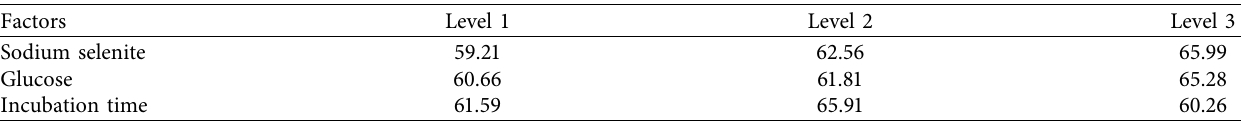
Table 2: The main effects of different levels of sodium selenite, glucose, and the incubation time on growth inhibition of Candida albicans . Factors